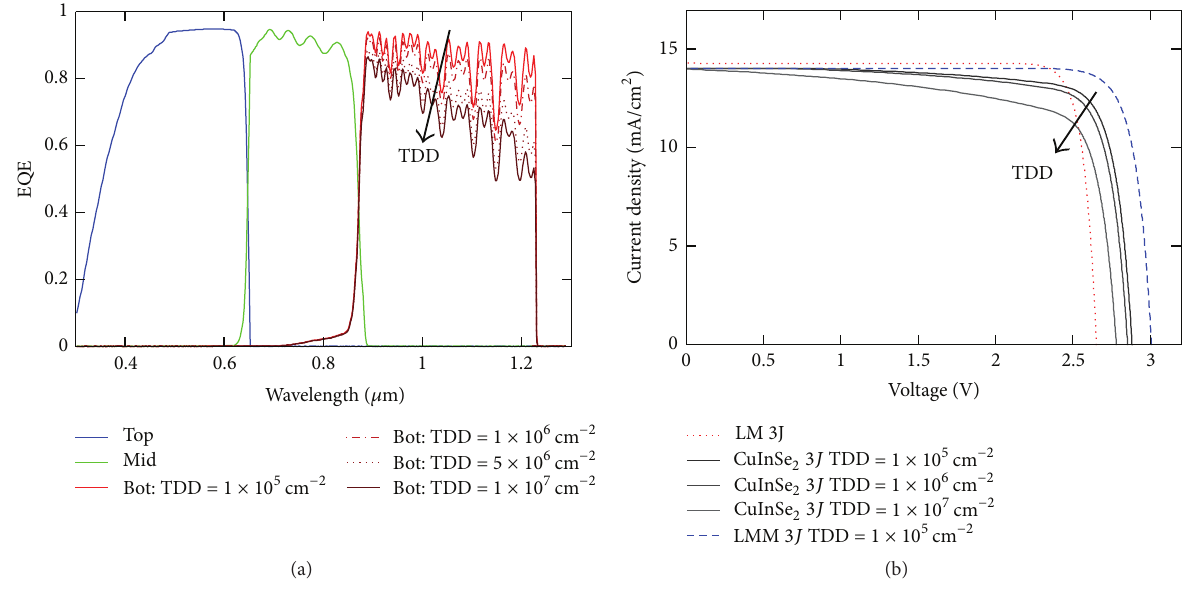
Figure 6: (a) Simulated EQE and (b) J-V characteristics of the CuInSe 2 3J for increasing levels of TDD bot in the bottom subcell at 1000W/m 2